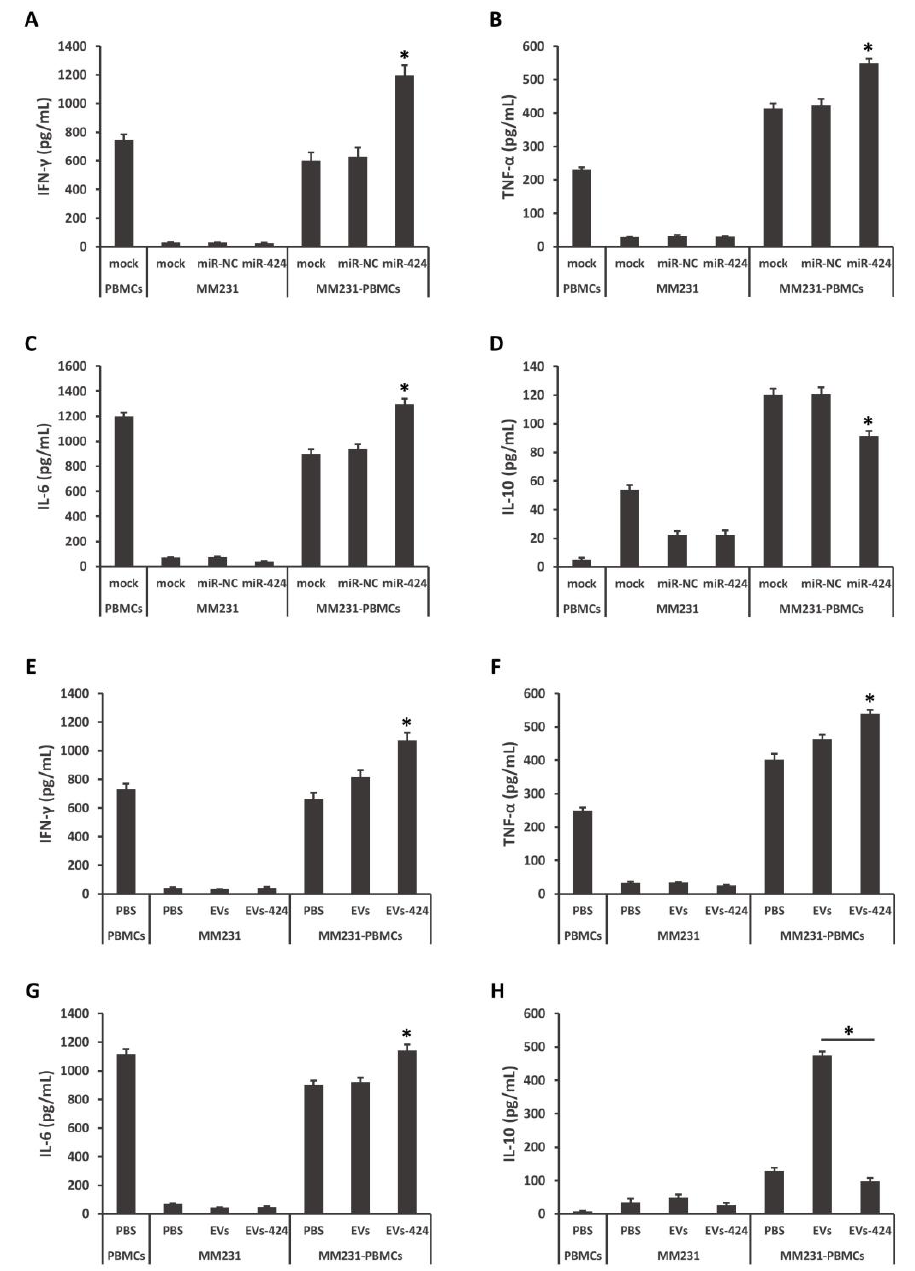
Figure 5. miR-424-5p regulates cytokine secretion in coculture model of MM231/peripheral blood mononuclear cells (PBMCs). MM231 cells were transfected with miR-424-5p mimics ( A – D ) or incubated with EVs-424 or EVs ( E – H ), and then cocultured with stimulated PBMCs for 16 h. The coculture medium was analyzed for IFN- γ ( A , E ), TNF- α ( B , F ), IL-6 ( C , G ) and IL-10 ( D , H ) by ELISA. * p < 0.05.